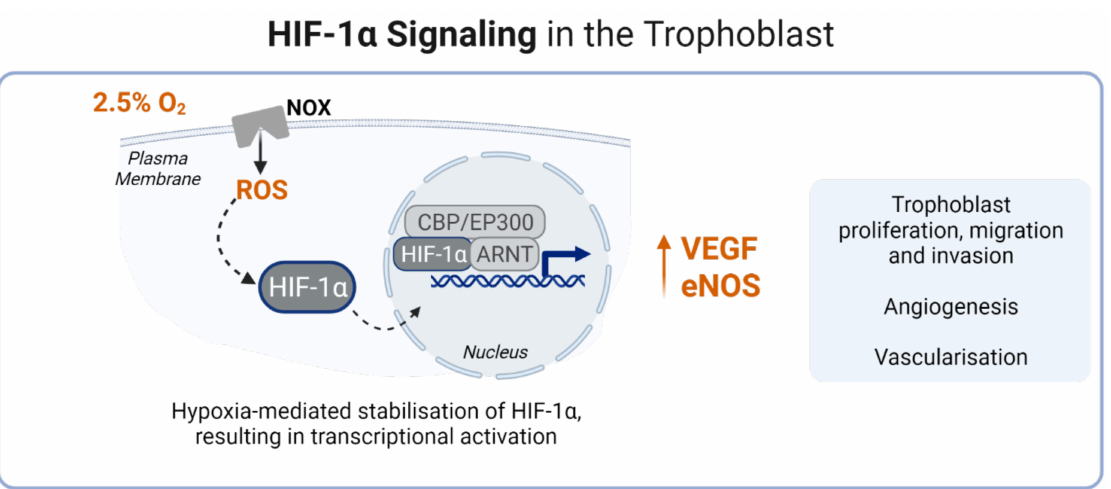
Figure 1. HIF-1 α signalling in the trophoblast, during the first trimester. Dashed arrows indi- cate activation, upright arrow indicates increase, blue arrow indicates transcription, black arrow indicates